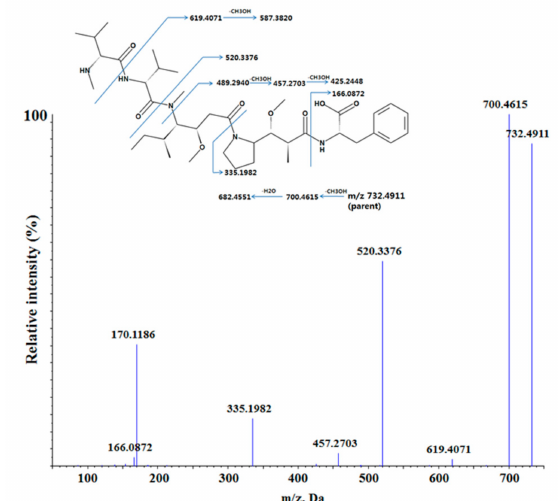
Figure 4. The proposed fragmentation pattern of MMAF (monomethyl auristatin F) in positive ion